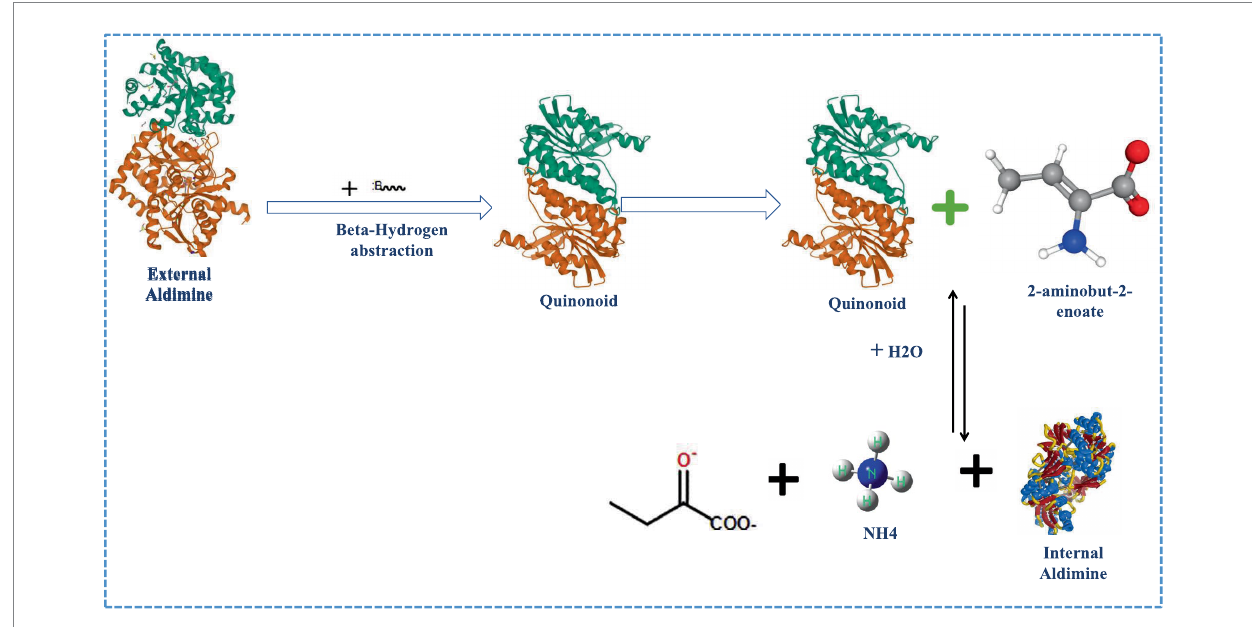
FIGURE 1 Elucidation of route1 (Direct β -hydrogen extraction) for ACC metabolism by ACC